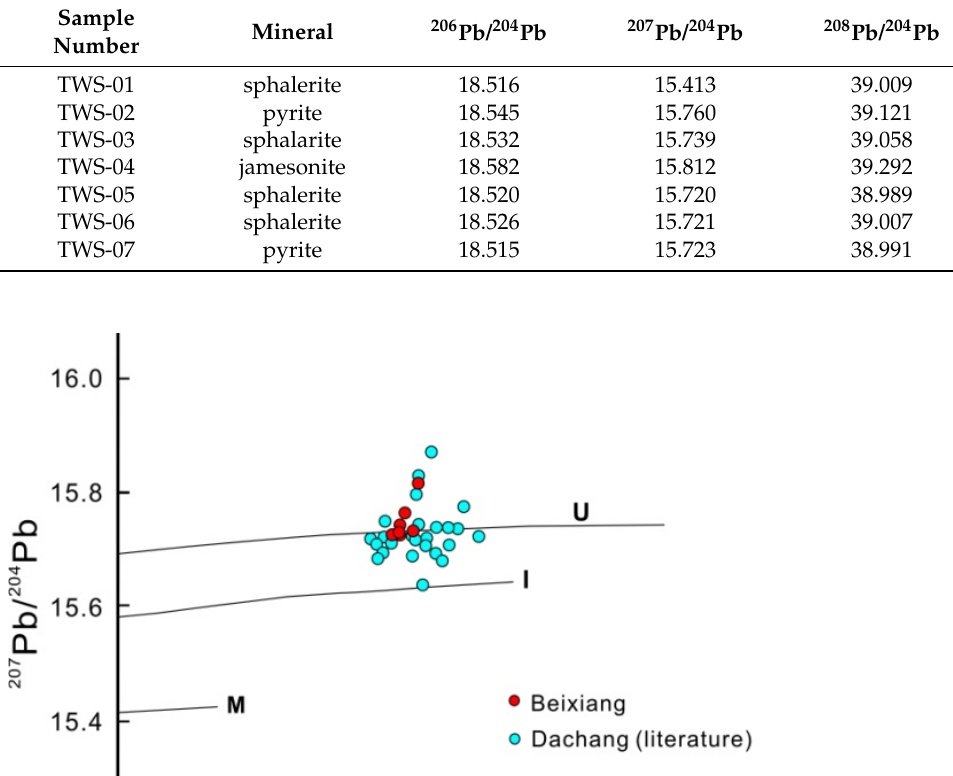
Table 4. Pb isotopic compositions of the Beixiang deposit.